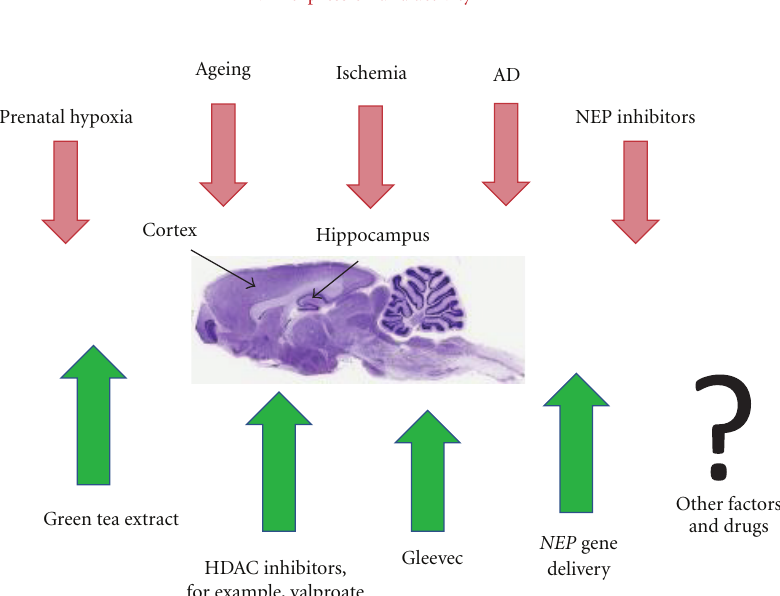
Figure 2: E ff ects of various experimental conditions on NEP activity in vivo . As explained in the text, NEP expression and activity in brain cortex and hippocampus (the structures which are characterised by accumulation of amyloid deposits) decreases with age and is also decreased after prenatal hypoxia, ischemia, or in the case of AD. In animal models, NEP activity can be modulated by its inhibitors a ff ecting such brain functions as learning and memory. Mechanisms which can control and upregulate NEP expression and increase its activity include targeted NEP gene delivery, regulation of its promoter via inhibition of HDACs or pharmacologically by green tea extract (or EGCG) or